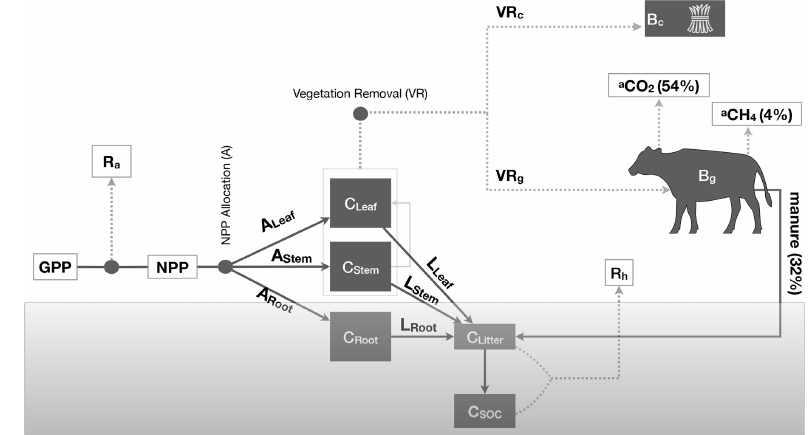
Figure 1. Schematic description of the DALEC-Grass model. DALEC-Grass simulates the dynamics of five C pools (C): leaf, stem, roots, litter and SOC. C is allocated to the five C pools via NPP allocation (A) and litter production (L). Vegetation removals (VRs) can occur due to grazing or cutting. DALEC-Grass determines whether a vegetation removal is caused by grazing, cutting or neither (see Sect. 2.2.2). When cutting is simulated (VR c > 0), cut biomass ( B c ) is removed from the ecosystem. When grazing is simulated (VR g > 0), 32% of grazed biomass ( B g ) is converted to manure, 54% of grazed biomass ( B g ) is converted to animal respiration ( a CO 2 ) and 4% of grazed biomass ( B g ) is converted to methane ( a CH 4 ). Dotted lines ( ··· ) show outward fluxes of C. Solid lines (—) show internal and inward fluxes of